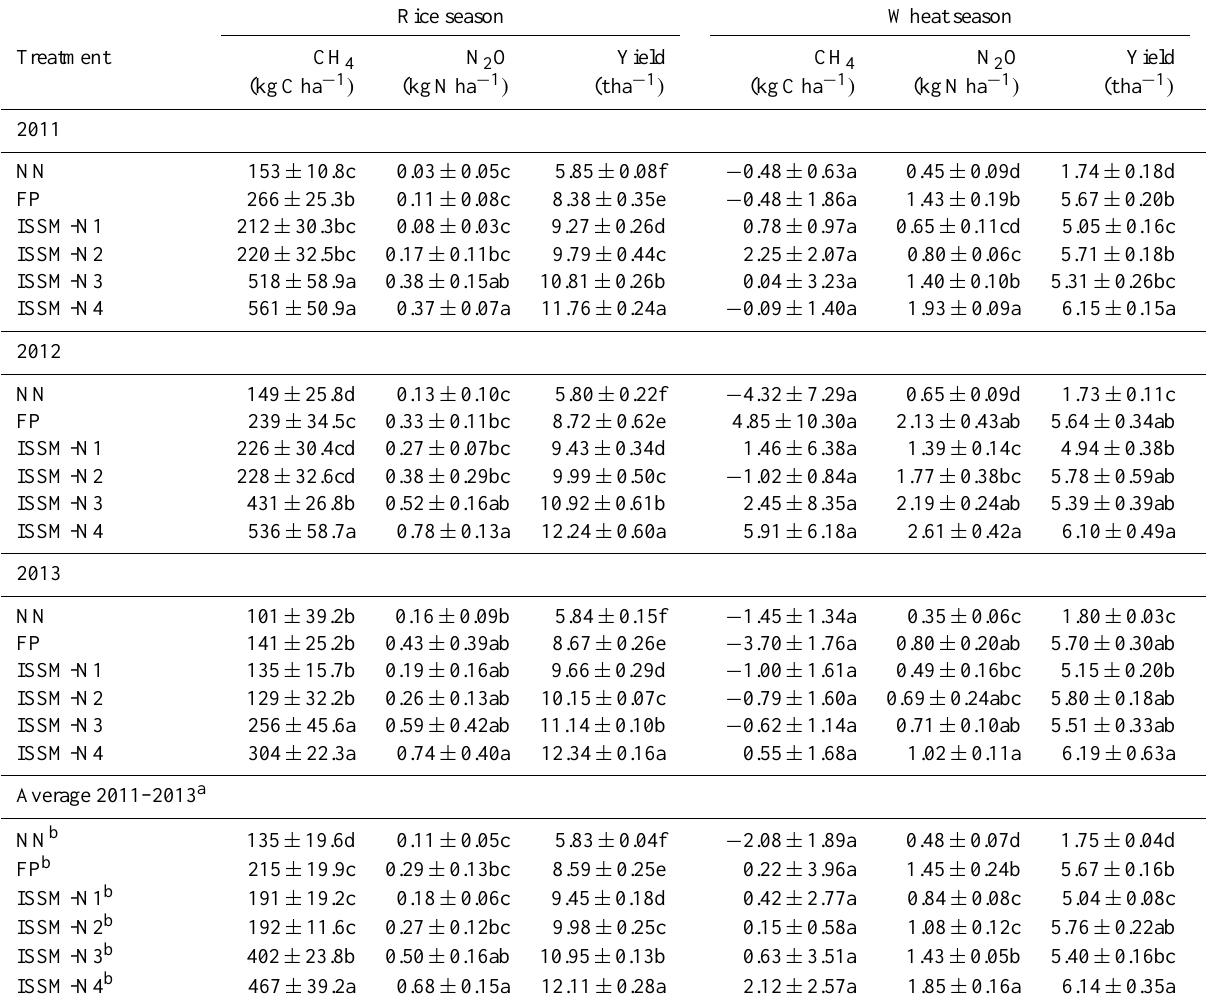
Table 3. Seasonal CH 4 and N 2 O emissions, and yields during rice and wheat cropping seasons in the three cycles of 2011–2014. Rice season Wheat